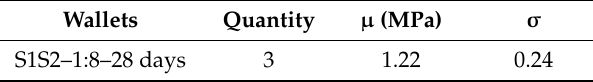
Table 6. Wallet’s compressive strength test results